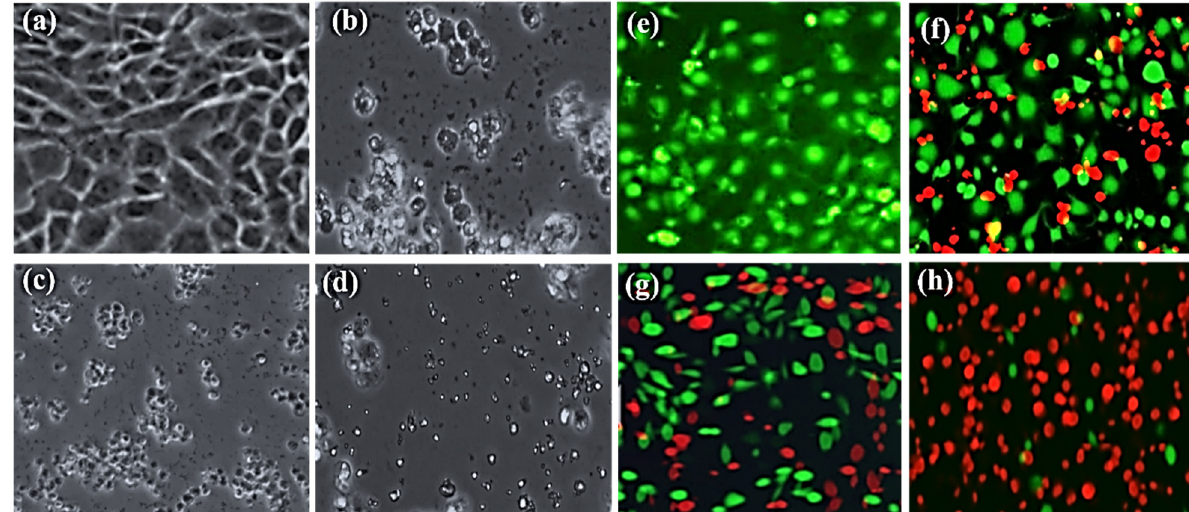
Figure 7. The morphological alterations in MCF-7 cancer cells after treatment with ( b ) plant extract, ( c ) chemically synthesized Cr 2 O 3 nanoparticles, and ( d ) green synthesized Cr 2 O 3 nanoparticles. The live/dead MCF-7 cancer cells stained with green and red fluorescent dye respectively after treatment with ( f ) plant extract, ( g ) chemically synthesized Cr 2 O 3 nanoparticles, and ( h ) green synthesized Cr 2 O 3 nanoparticles. ( a ) and ( e ) controls. (Scale bar = 100 µm).